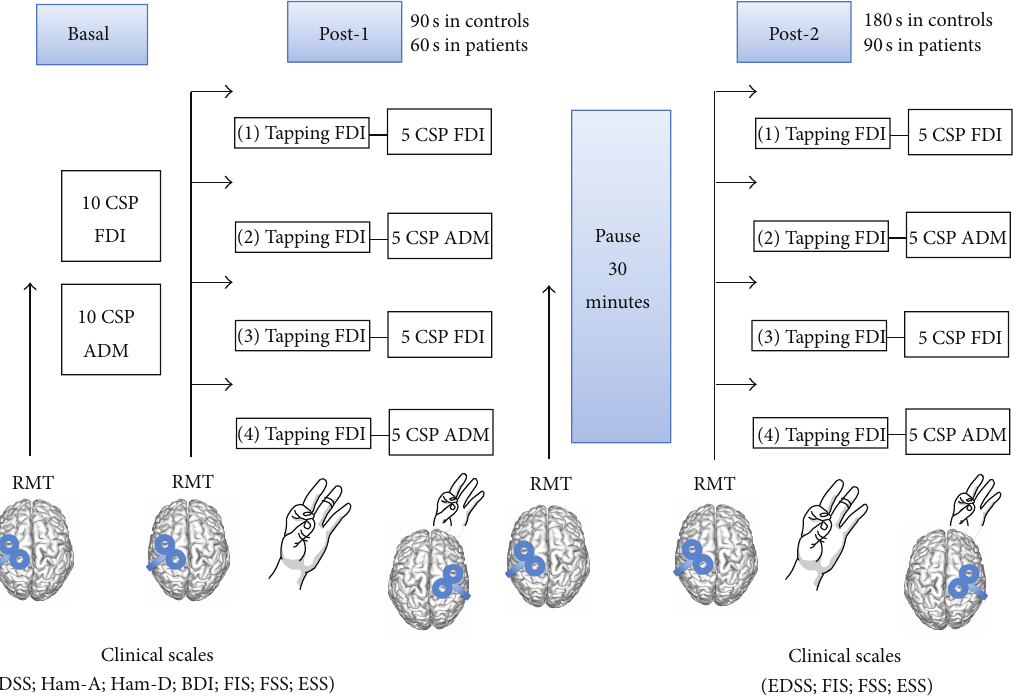
Figure 1: Protocol and time-table of the study. In MS patients, Post-1 and Post-2 blocks were repeated before and after chronic treatment with amantadine 200mg/die for three